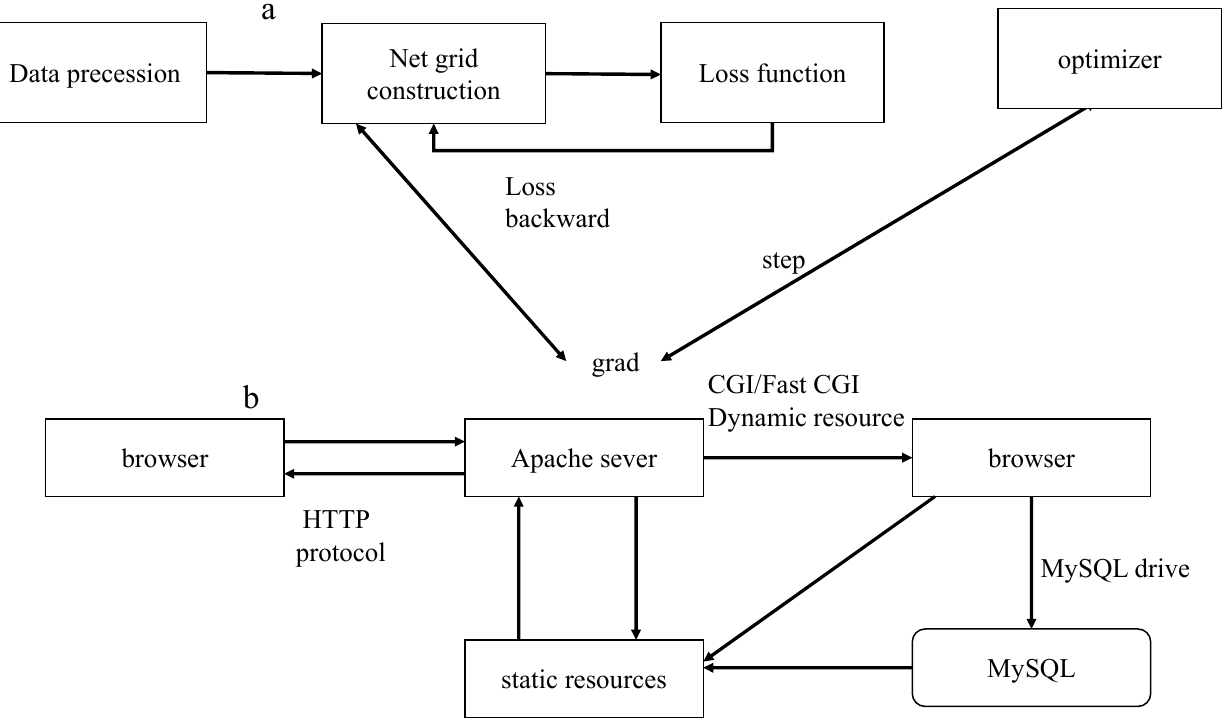
Figure 1. Pytorch model building flow chart ( a ); LAMP working principle diagram ( b ).